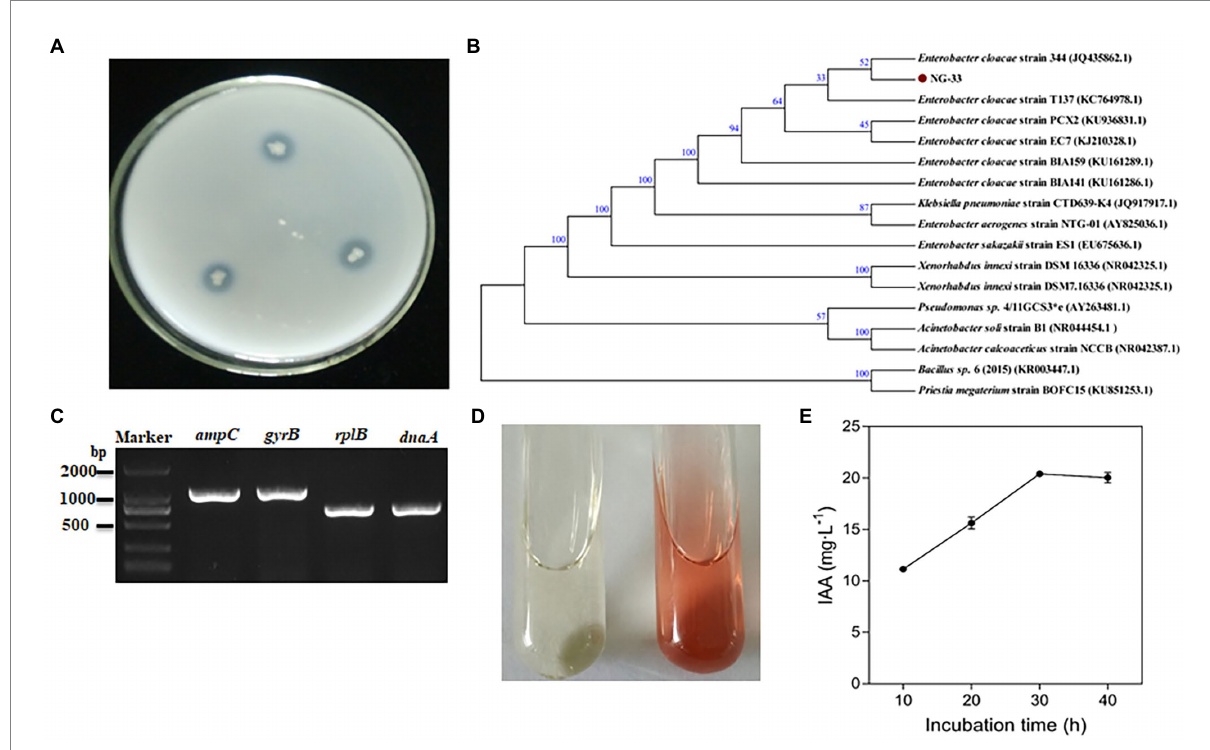
FIGURE 1 Characteristics of Enterobacter cloacae NG-33. (A) Bacteria grown for 3 days at 37 ° C on NBRIP plate culture. (B) Neighbor-joining phylogenetic dendrogram based on 16S rDNA sequences showing relationships between the NG-33 strain and their closest taxa. The numbers at the nodes indicate the levels of bootstrap support based on data for 1,000 replicates; only values greater than 50% are presented. The scale bar represents the observed number of changes per nucleotide position. (C) The PCR products of four genes ( dnaA , gyrB , ampC and rplB ) of Enterobacter